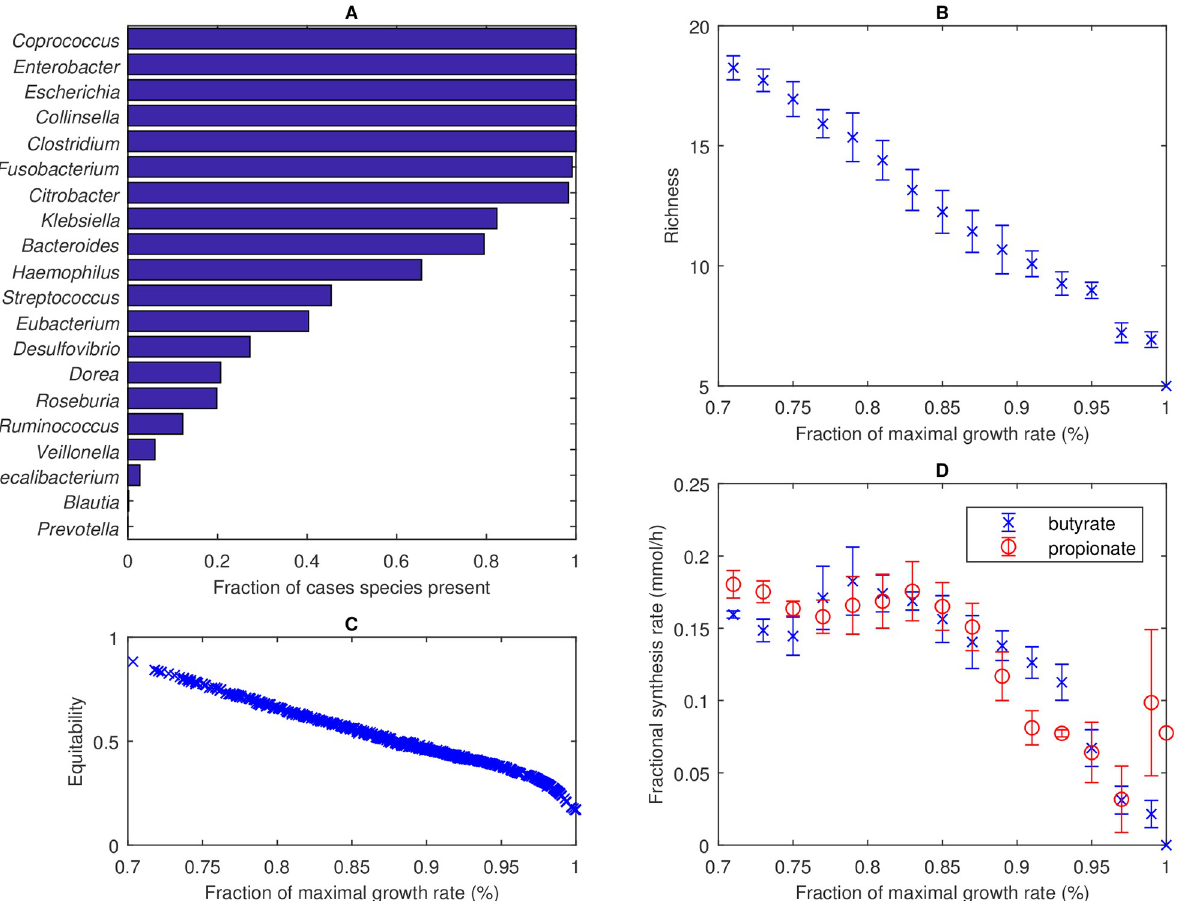
Fig 5. Optimized 20-species communities for the Western diet with species abundance bounds calculated from community FVA solutions. (A) Fraction of the 575 simulation cases for which the species abundance exceeded 1%. (B) Binned community richness, defined as the number of species with abundances greater than 1%. Results of the 575 cases were collected into 15 bins centered at growth rates ranging from 0.71 to 0.99 of the maximal value. The symbols represent the mean and error bars represent the standard deviation in each bin. (C) Equitability measure D com calculated for all 575 cases. (D) Binned fractional butyrate and propionate